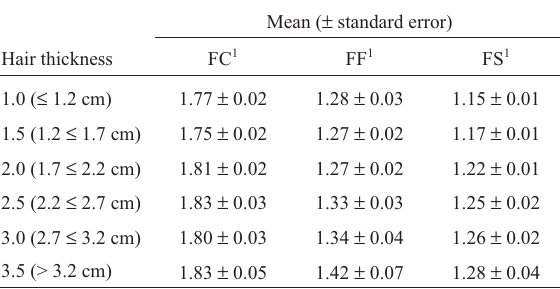
Table4 -Leastsquaremeans( ± standarderror)ofnumberoffliescounted on animals (FC), number of flies in photographs (FF), and of infestation score (FS), according to hair coat thickness.